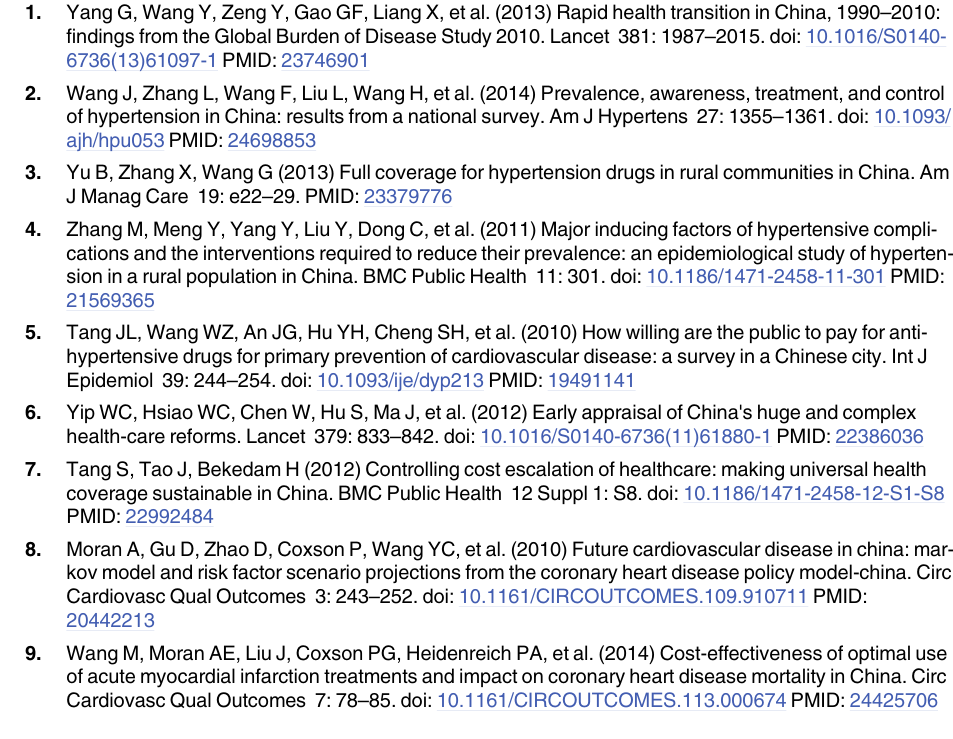
S5 Table. Detailed effectiveness and drug cost assumptions for systolic BP. S6 Table. Distributions of main input parameters used in probabilistic sensitivity analyses. S7 Table. Cost effectiveness hypertension control in Chinese adults with and without add- ing separate components of program